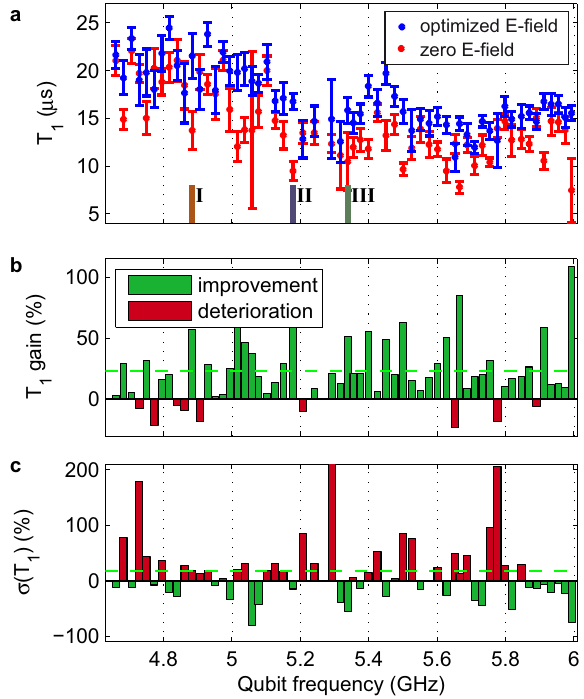
Fig. 2 Benchmarking the optimization algorithm. Rows I – III were taken at the indicated qubit operation frequencies. a Qubit T 1 -time vs. applied electric fi eld. Black data points are obtained from fi ts to exponential decay curves as shown in Fig. 1d. Dips in T 1 indicate the resonance with strongly coupled TLS. The gray curve is a 3-point nearest neighbor average, whose maximum (blue circle) is close to the determined optimum bias fi eld. The green line indicates T 1 obtained in the second pass, sweeping the fi eld in fi ner steps in a small range around the E- fi eld of previously determined T 1 maximum. b Comparison of qubit T 1 times between an optimized E- fi eld bias (blue data) vs. zero applied E- fi eld (red data), measured as a function of time during 30 min.